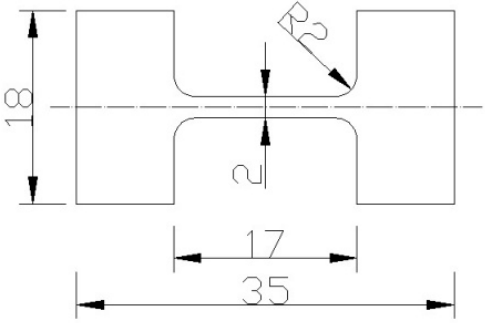
Figure 1. Diagram of AZ61 Mg alloy samples for slow strain rate tensile test (SSRT) (unit: mm).